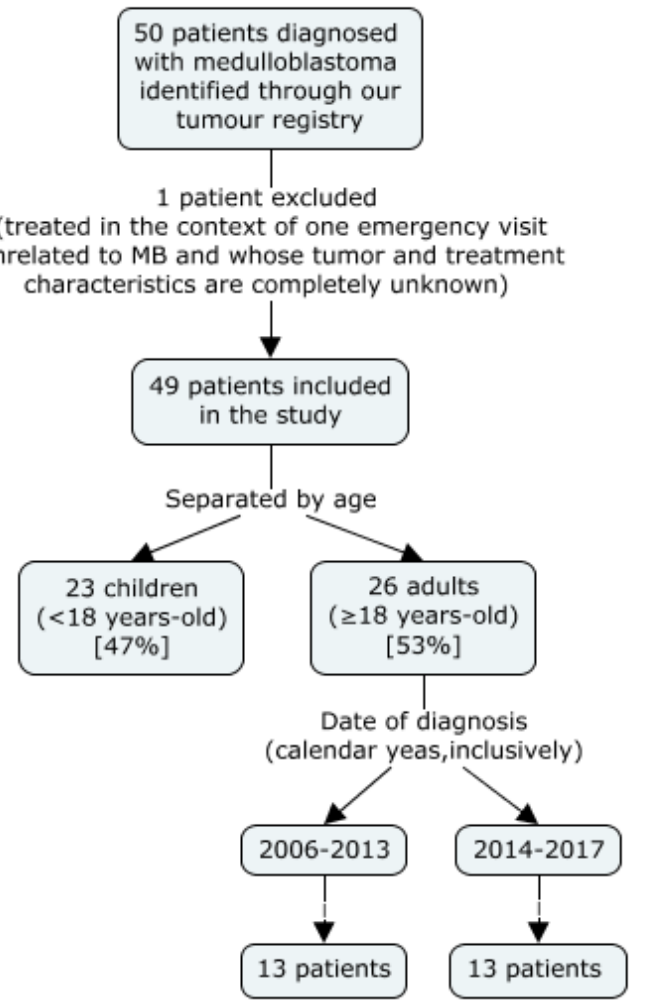
Figure 1. Patient Selection and Distribution.